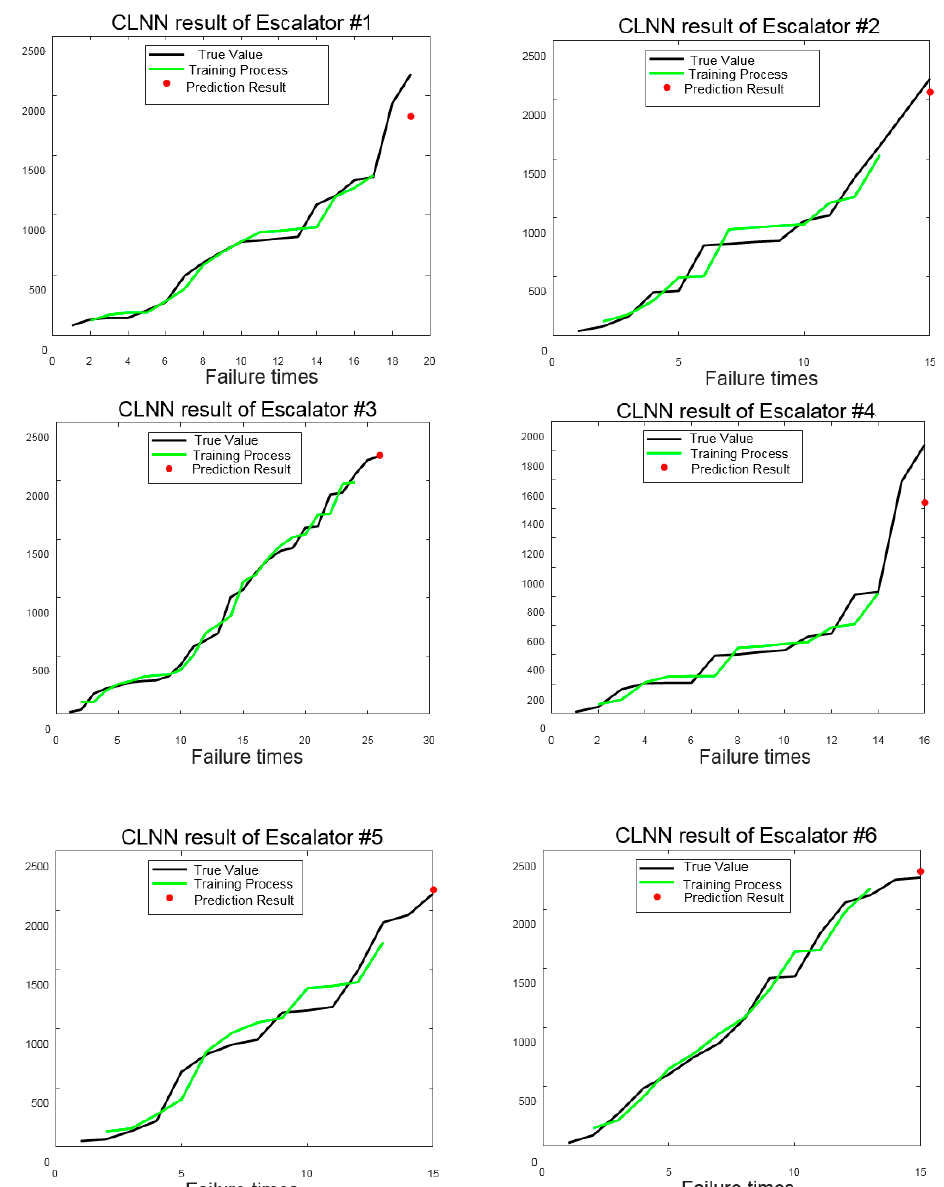
Figure 13. Training process and prediction result using CLNN directly.